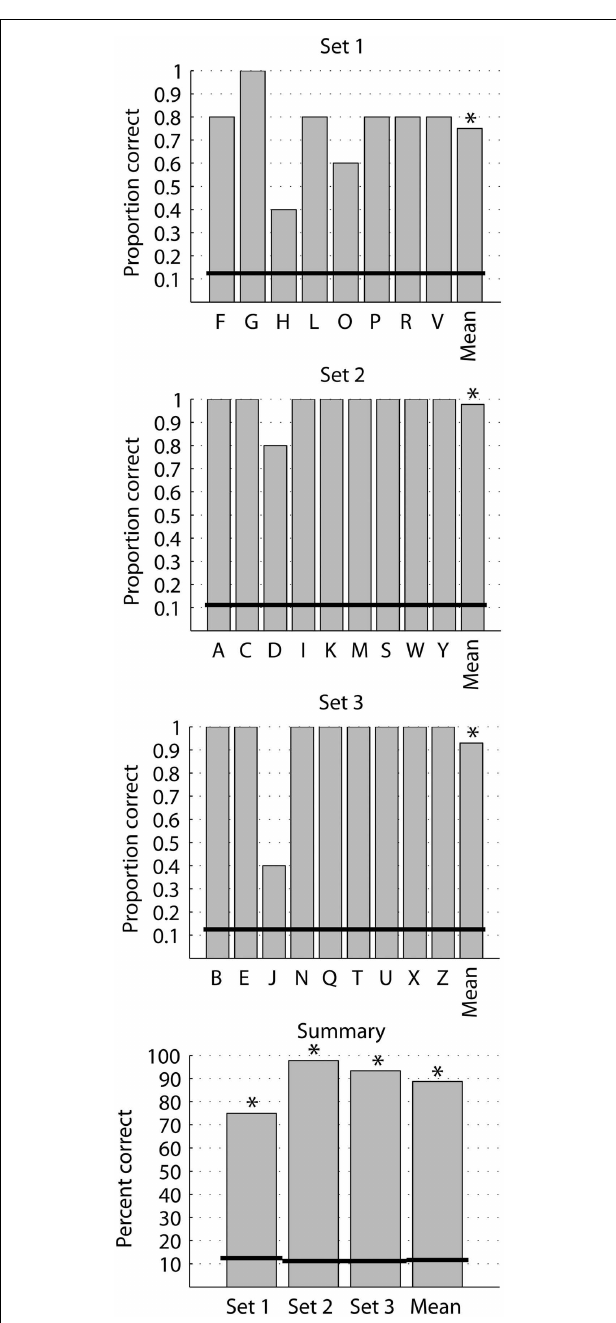
FIGURE 3 | Identification of single letters. Proportion correct of identification of single letters in set 1 (8 AFC), set 2 (9 AFC), and set 3 (9 AFC) and the summary percent correct. Each letter was presented five times in random order within its set.The black horizontal lines denote chance level for the respective set. * p < 0.001 (binomial probability distribution).